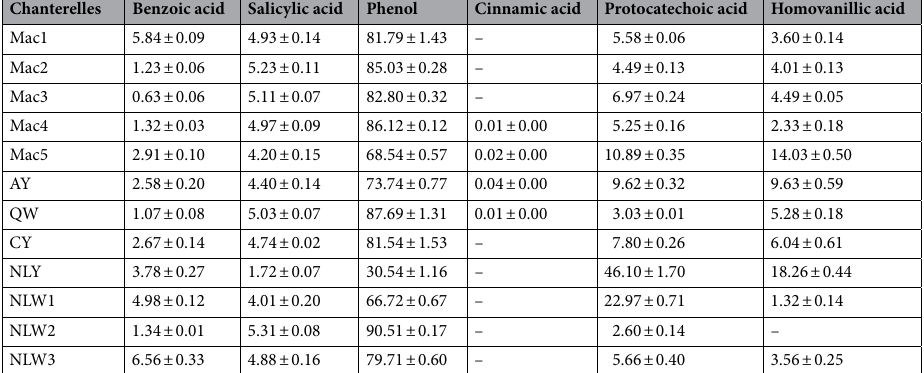
Table 3. Phenolic acid compounds (nanomole percent ± standard error) observed in white and golden variants of Newfoundland chanterelles. Values (nanomole percent by weight composition) represent means ± standard errors for four replicates. Sample codes AY: Cantharellus betularum (golden); CY: C. camphoratus (golden); Mac1–Mac5: individuals from a mixture of golden and white NL chanterelles; NLW1–3: C. enelensis (Newfoundland, white 1–3); NLY: C. enelensis (Newfoundland, golden); QW: C. enelensis (Québec,